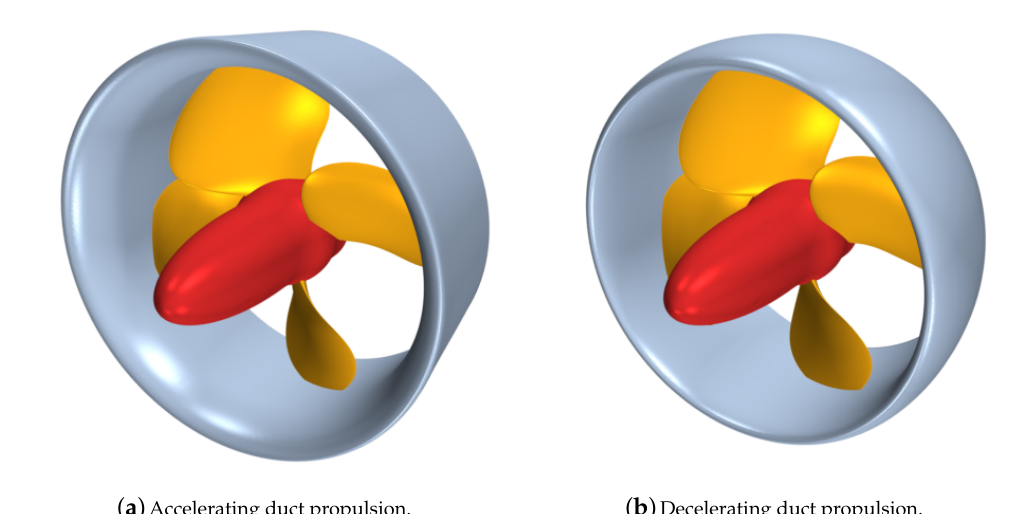
Figure 1. 3-D view of the propellers equipped with the